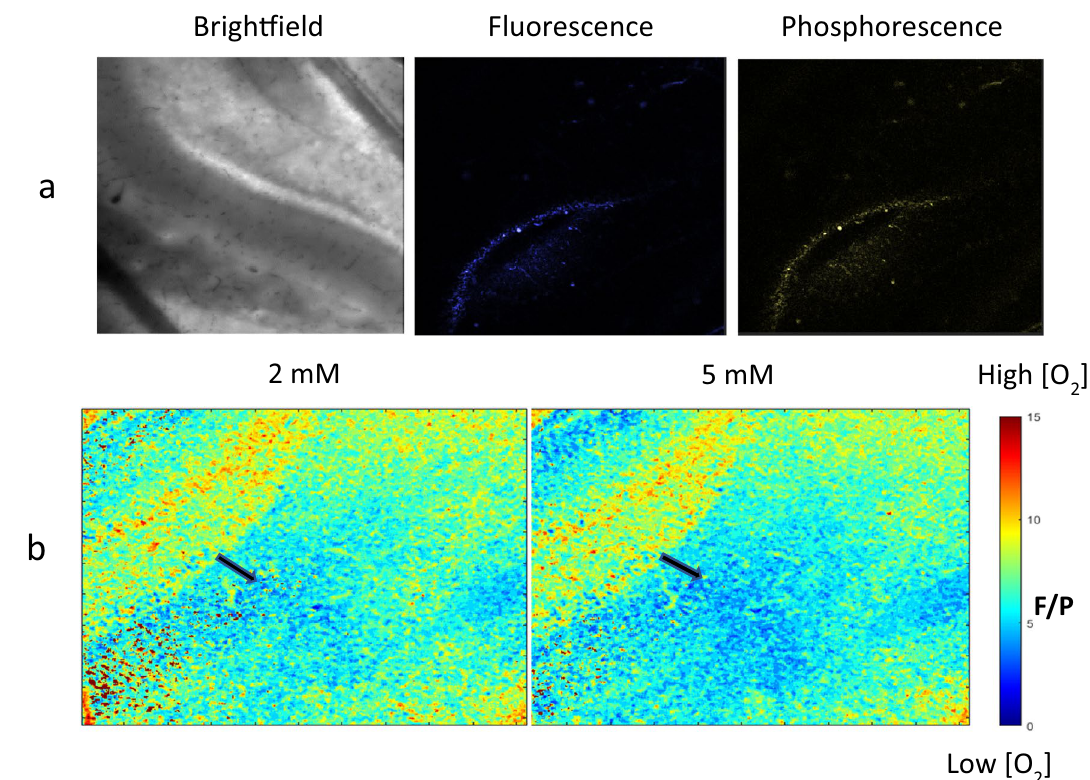
Figure 5. Potassium concentration effect on neuronal activity. ( a ) Ratiometric images under low K + (2 mM) and high K + (5 mM) concentration. ( b ) Ratiometric imaging in the presence of 2 mM and 5 mM extracellular KCl. Black arrows mark the regions with lower oxygen.